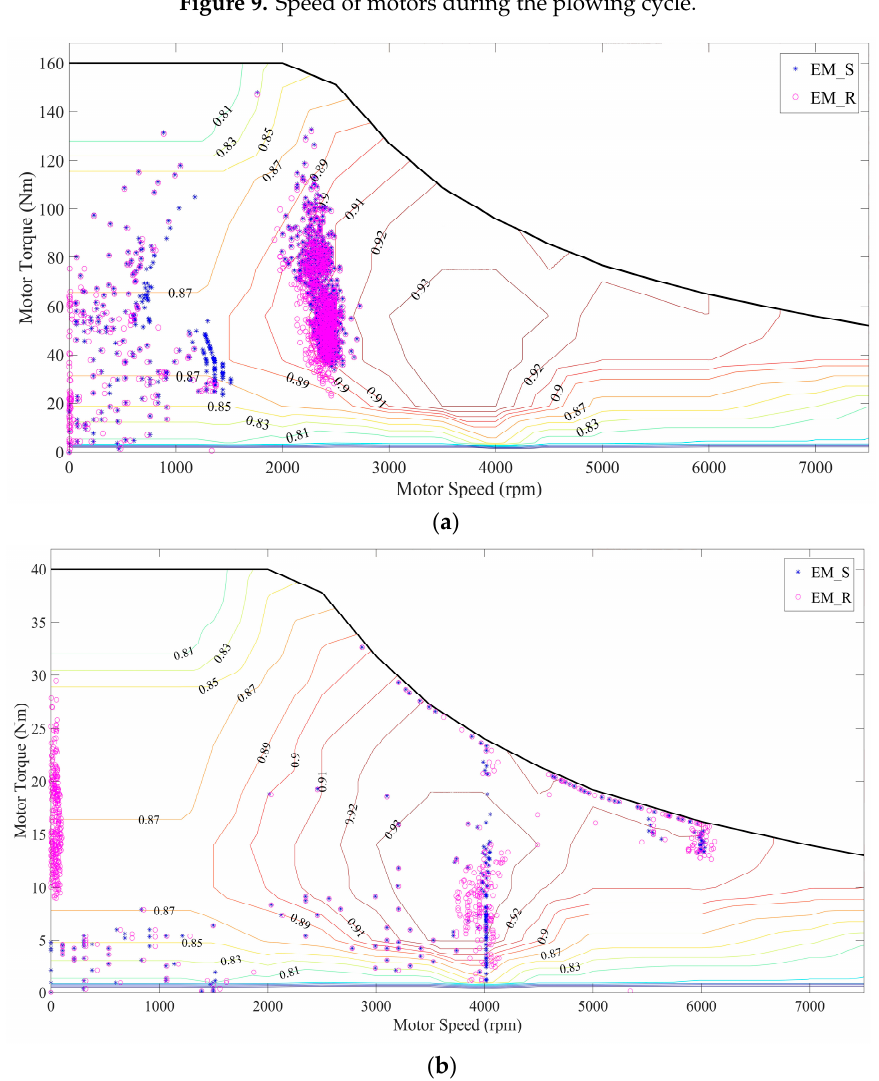
Figure 10. ( a ) Working points of EM_S at PDR = 0.8 and EM_R at PDR = 0.2; ( b ) working points of EM_S at PDR = 0.2 and EM_R at PDR = 0.8.